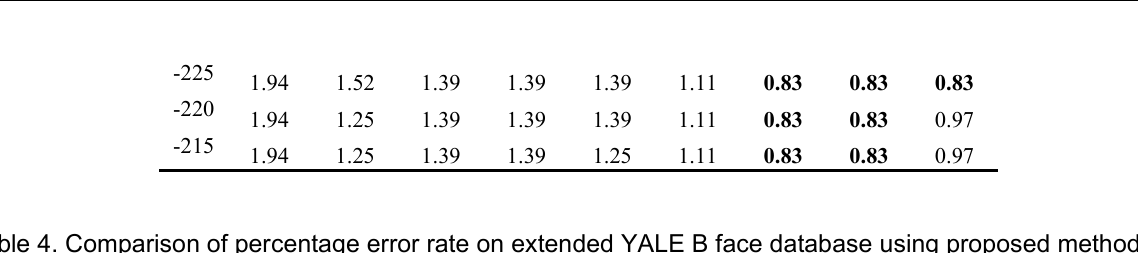
Table 4. Comparison of percentage error rate on extended YALE B face database using proposed method and existing state-of-art